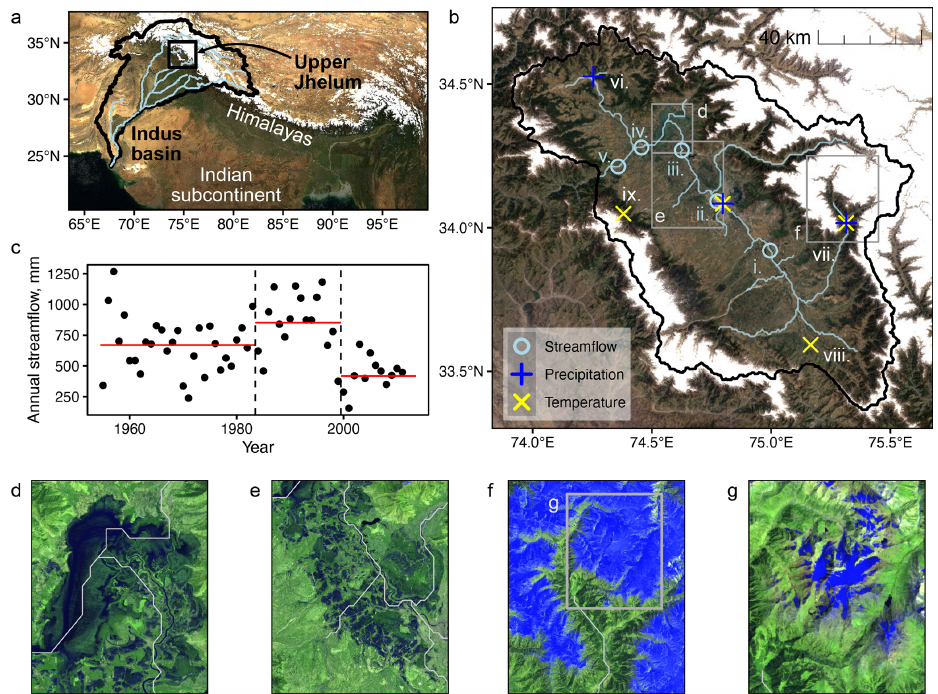
Figure 1. Study site and hydrological change. (a) Himalayan water towers, including the Indus basin and the location of the Upper Jhelum watershed. (b) Upper Jhelum watershed, including locations of streamflow records (gauges i–v), climate records (stations ii and vi–ix), and bounding boxes for panels (d) – (f) . The streamflow gauge numbers refer to (i) Sangam, (ii) Munshi Bagh, (iii) Asham, (iv) Sopore, and (v) Baramulla. (c) Annual streamflow normalized by catchment area, with long-term averages for the periods 1955–1983 (670mm; no climate data), 1984–1999 (852mm; pre-2000 with climate data), and 2000–2013 (419mm; post-2000). The remaining panels highlight water storage within the Upper Jhelum watershed, including the (d) Wular Lake, (e) valley inundation, (f) snowpack in May, and (g) Kolahoi Glacier in August. In these images (d–g) , Landsat bands SWIR2–SWIR1–Red are mapped to red–green–blue so that vegetation, water, and snow are clearly visible as green, dark, and blue pixels, respectively. MODIS imagery in panel (a) (Vermote, 2015) and Landsat composite imagery in panels (b) , (d) – (g) from the U.S. Geological Survey were prepared and downloaded using Google Earth Engine (Gorelick et al.,